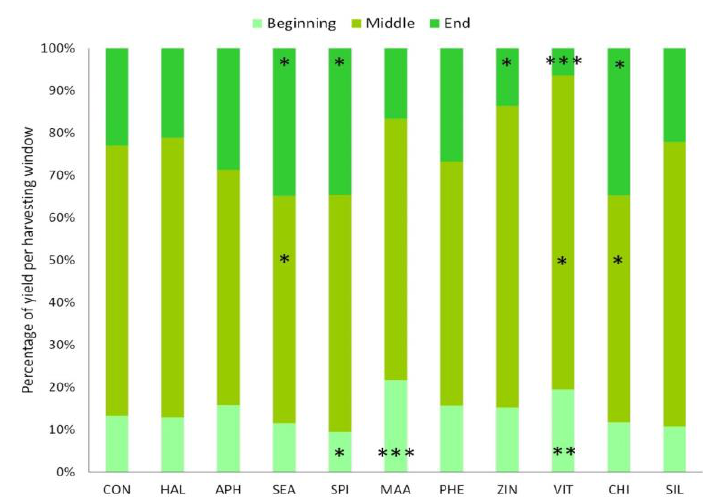
Figure 6. Percentage of the total yield per plant harvested during the three harvesting windows (beginning, middle, and end). n = 4. Asterisk indicates significant differences between a single treatment group and control group within a harvesting window, according to Dunnett’s test. *** P < 0.001; ** P < 0.01; * P < 0.05; no asterisk indicates absence of any significant